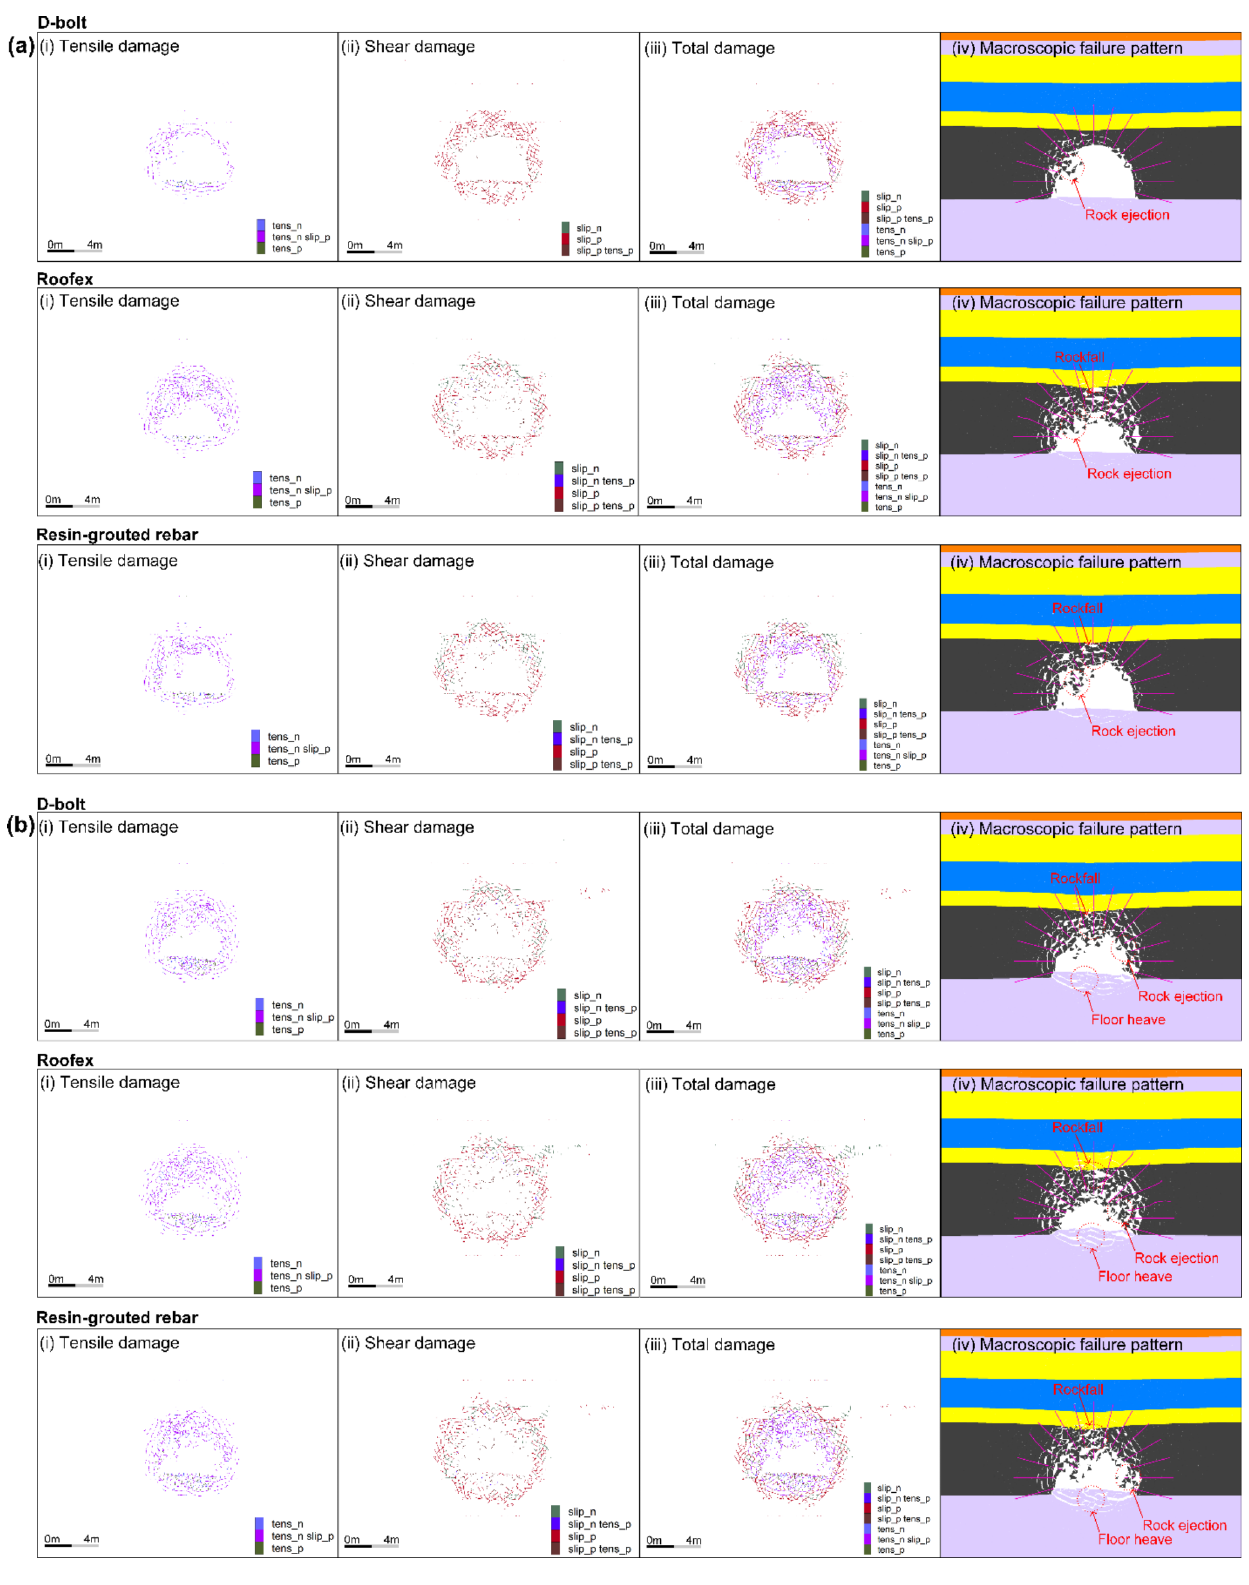
Fig. 17 Distribution of cracks and macroscopic failure patterns of the tunnel supported by different types of rockbolts. a PPV = 0.2 m/s; b PPV = 0.8 m/s